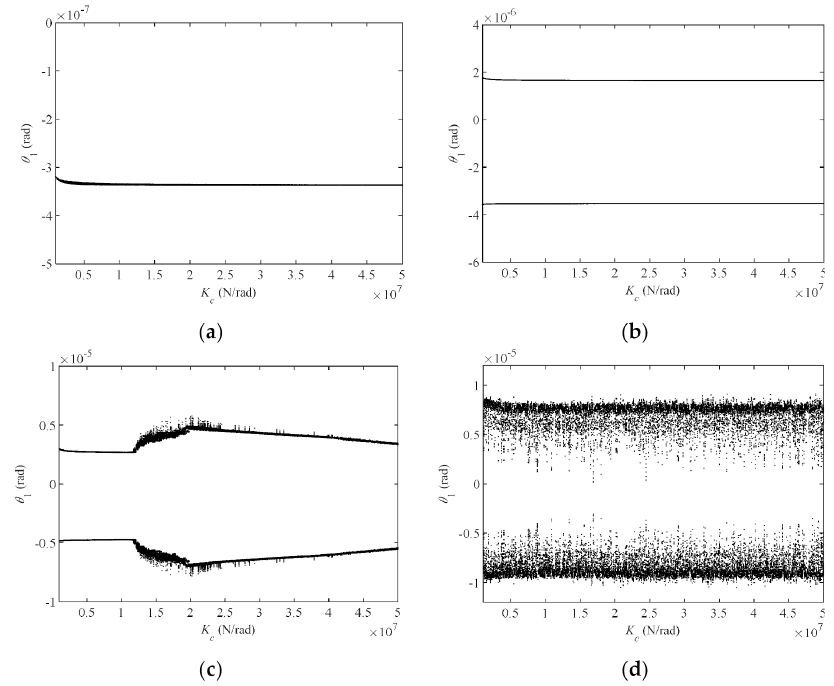
Figure 8. Bifurcation diagram of vibration response varying with K c at different speeds: ( a ) ω = 500 rad/s; ( b ) ω = 800 rad/s; ( c ) ω = 1100 rad/s; ( d ) ω = 1800